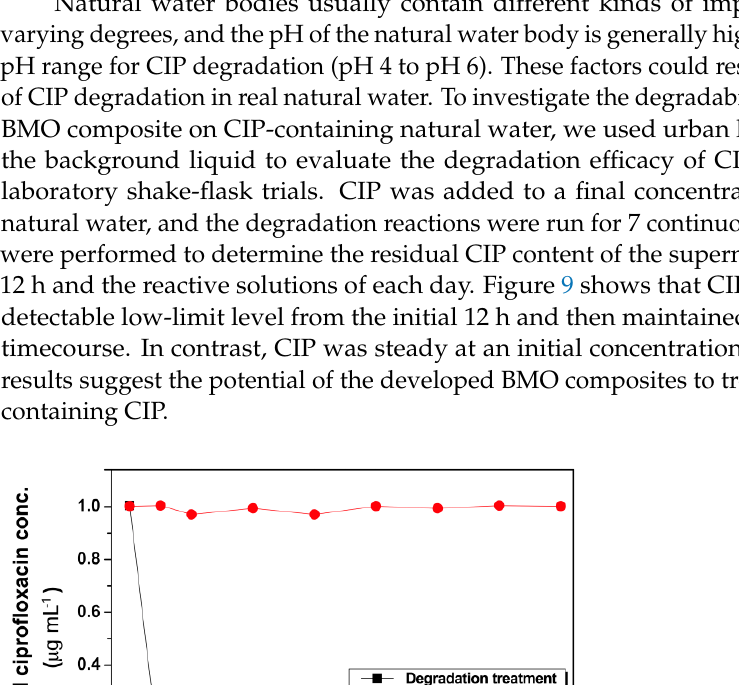
Figure 8. Continuous four-round degradation of CIP by the BMO composites.